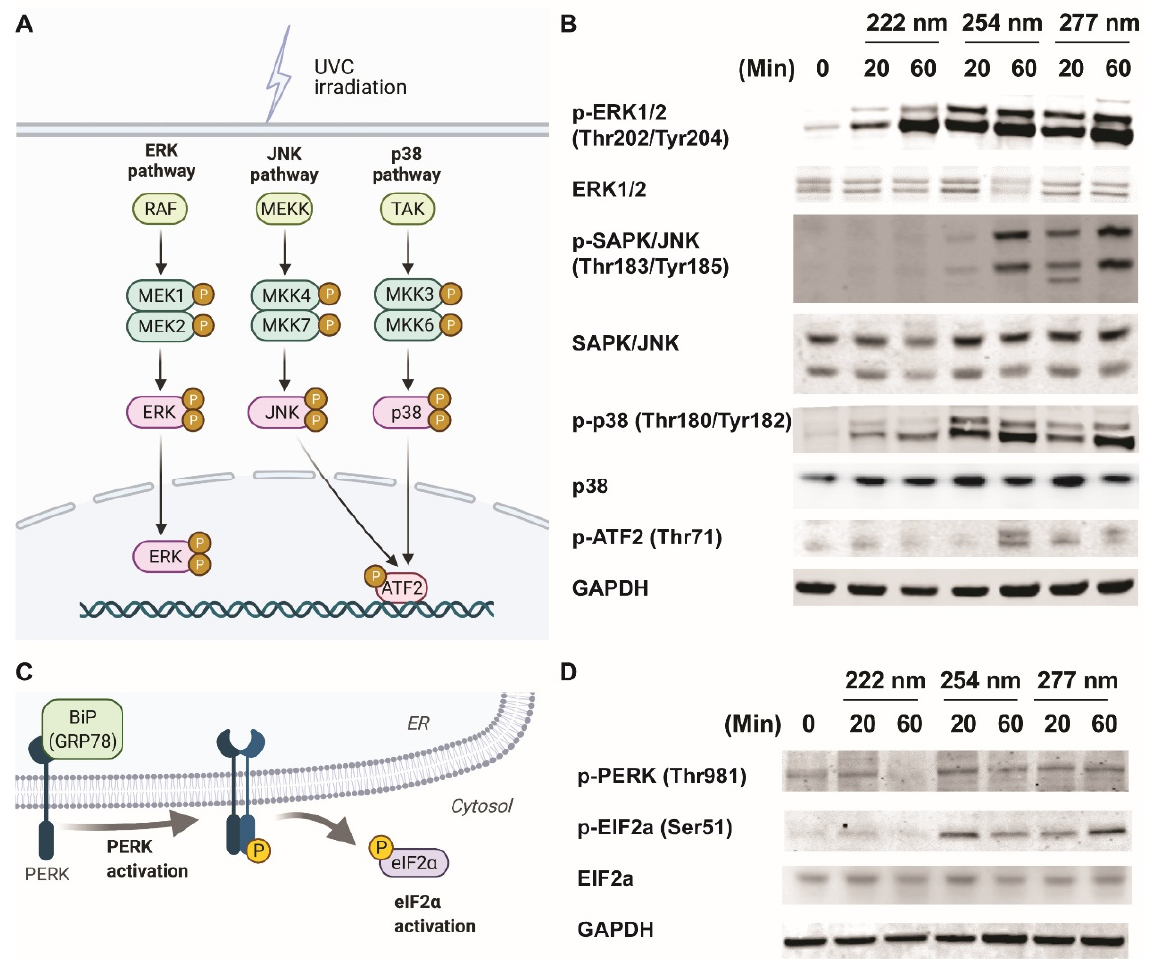
Figure 2. Differential activation of MAPK and ER-stress signaling pathways results in the differential activation of apoptotic pathways. ( A ) Schematic indicating the classical MAPK signaling pathways studied due to classical 254-nanometer UVC irradiation. ( B ) Representative Western blots of phosphor-ERK (Thr202, Tyr204), total ERK1/2, phosphor-JNK/SAPK (Thr183, Tyr185), total JNK1/2, phosphor-p38 (Thr180, Tyr182), p38, phosphor-ATF2 (Thr69), and GAPDH from ARPE-19 cells exposed to 0, 20, and 60 min of respective UVC wavelengths. ( C ) Schematic indicating the proteins involved in endoplasmic-reticulum-induced stress pathway. ( D ) Representative Western blots of phosphor-PERK (Thr980), total ERK1/2, phosphor-EIF2a (Ser49), EIF2a, and GAPDH from ARPE-19 cells exposed to 0, 20, and 60 min of respective UVC wavelengths.